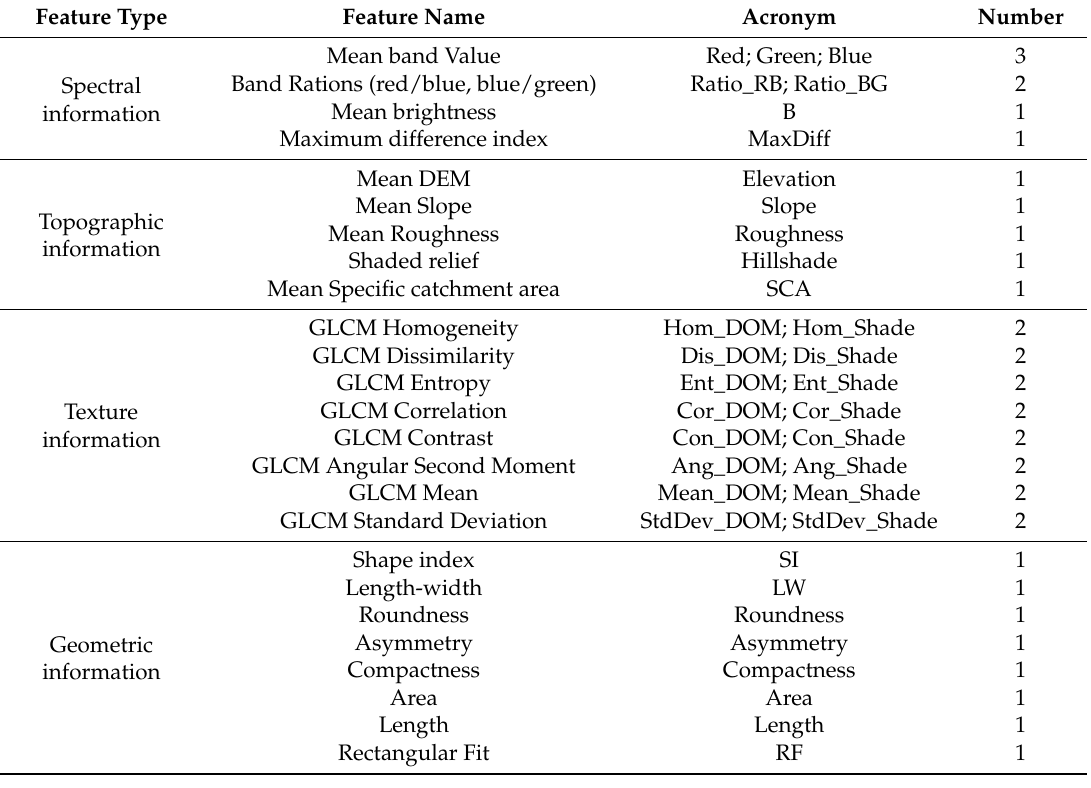
Table 2. Overview of the features adopted for gully-affected areas detection in this